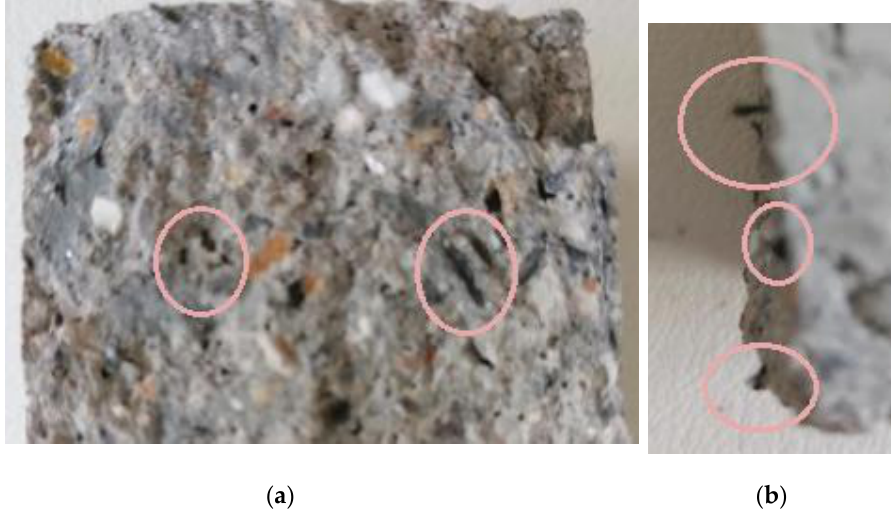
Figure 20. Compressed cement specimen with chopped carbon fiber reinforcement ( a ) Front view of broken sample ( b ) side view of broken sample.